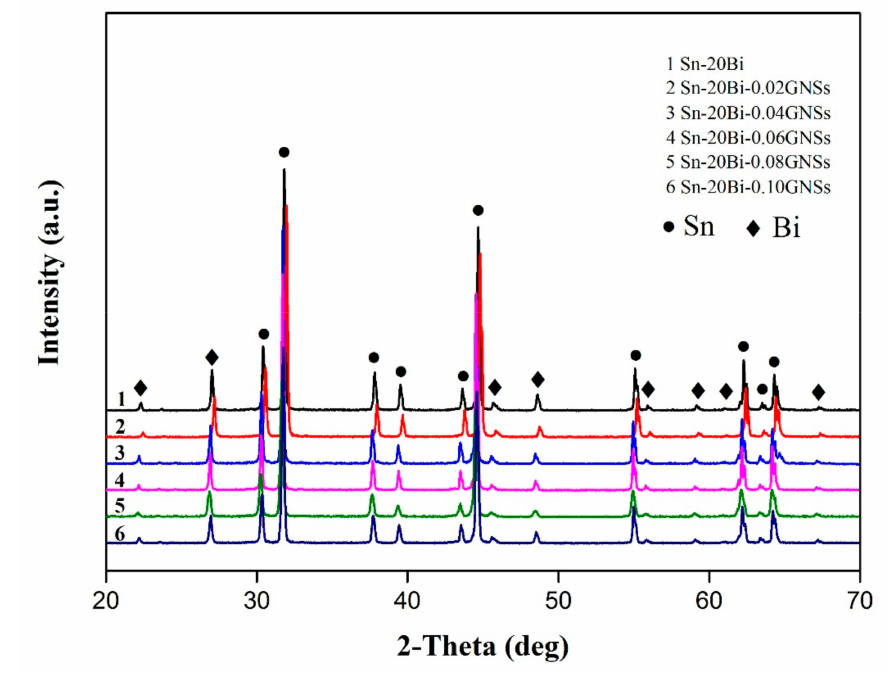
Figure 3. The XRD patterns of